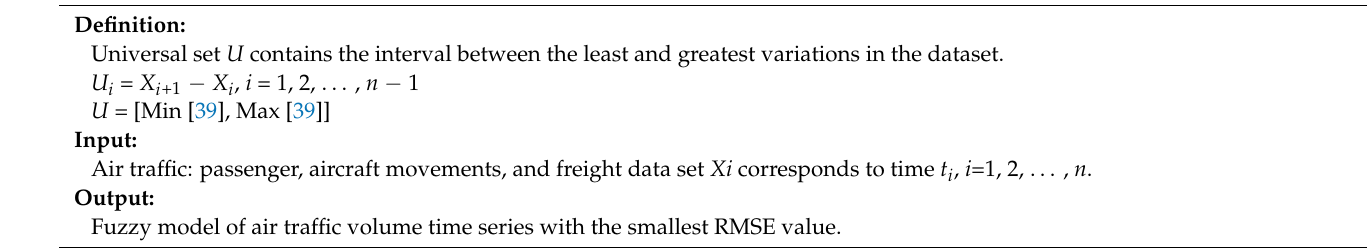
Algorithm 1: Fuzzy time series using variations of